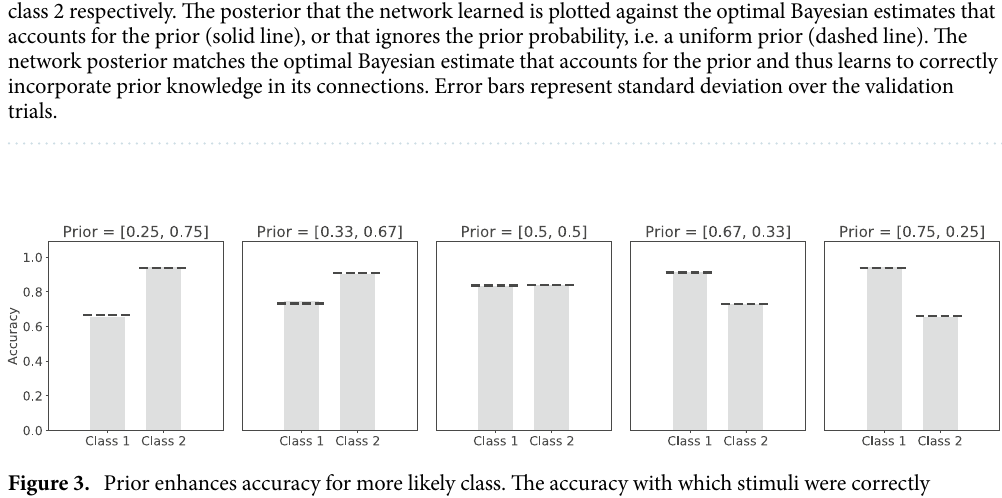
Figure 3. Prior enhances accuracy for more likely class. The accuracy with which stimuli were correctly classified was influenced by the prior probability of a certain class. A uniform prior (panel 3) led to equal accuracy on stimuli from both classes. A network trained on more stimuli from class 2 than class 1 (panel 1 and 2) showed higher accuracy on class 2 stimuli, but lower accuracy on class 1 stimuli, compared to the uniform prior. On the other hand a network trained on more stimuli from class 1 than class 2 (panel 4 and 5) showed higher accuracy on class 1 stimuli, but lower accuracy on class 2 stimuli, compared to the uniform prior. (Dashed line represents accuracy of optimal Bayesian